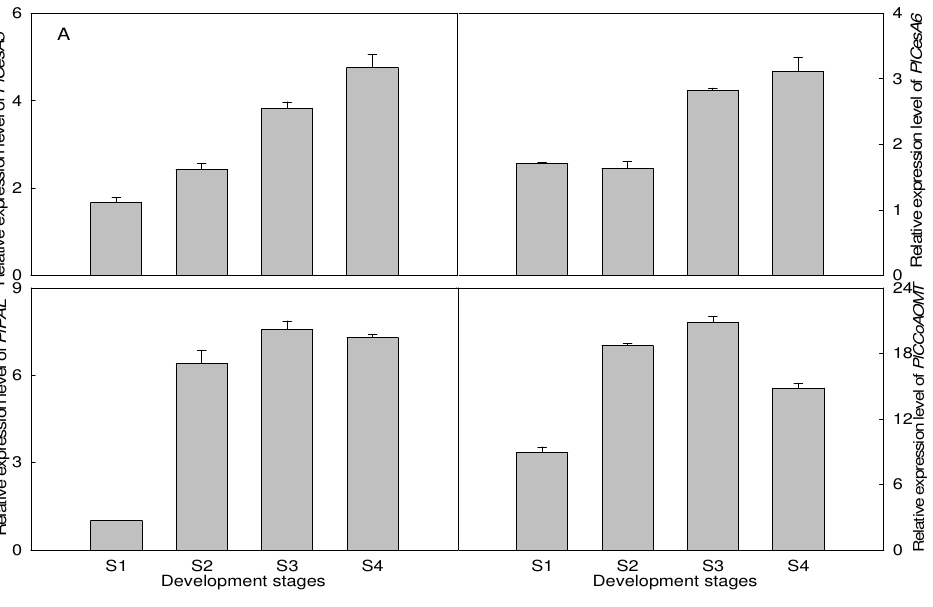
Figure 6. Expression levels of cellulose and lignin biosynthetic genes in tissues. ( A ) Gene expression levels in developmental inflorescence stems; ( B ) Gene expression levels in different